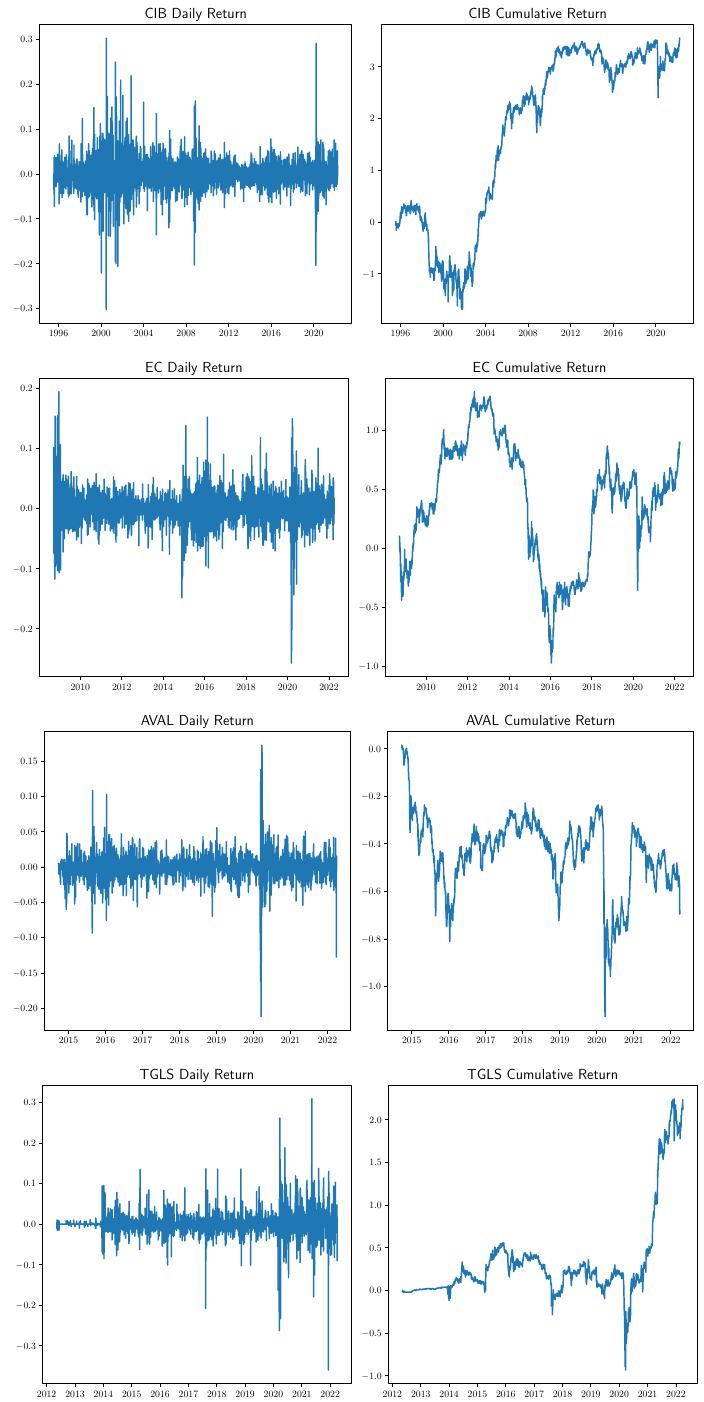
Figure 1. Daily and cumulative returns for Bancolombia, Ecopetrol, Grupo AVAL, and Tecnoglass shares. Source: Yahoo Finance API for